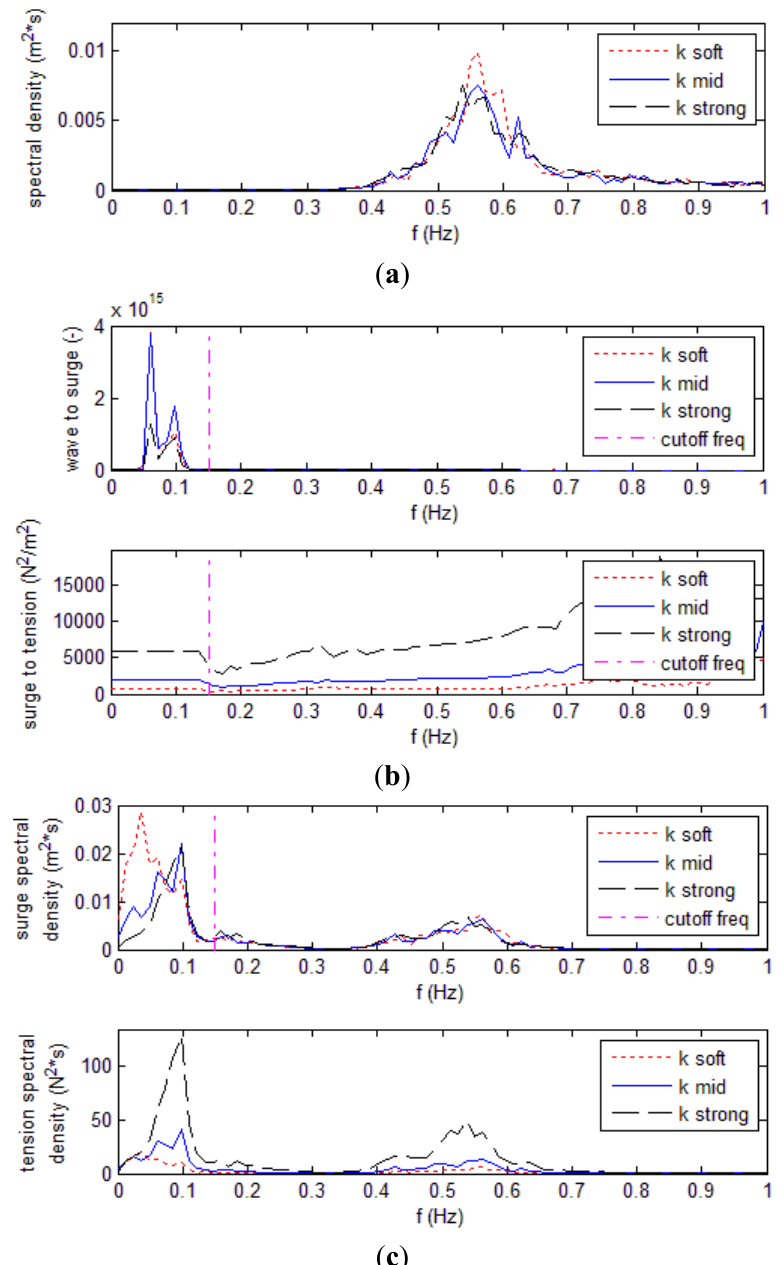
Figure 9. Frequency domain analysis of the system in design waves ( T and for the three springs tested. The cutoff frequency used in the surge signal reconstruction is shown by a vertical line at 0.15 Hz. ( a ) Incident wave spectra; ( b ) transfer functions from wave to surge and from surge to tension in the main mooring line; and ( c ) Spectral response of the system in terms of surge and tension in the main mooring